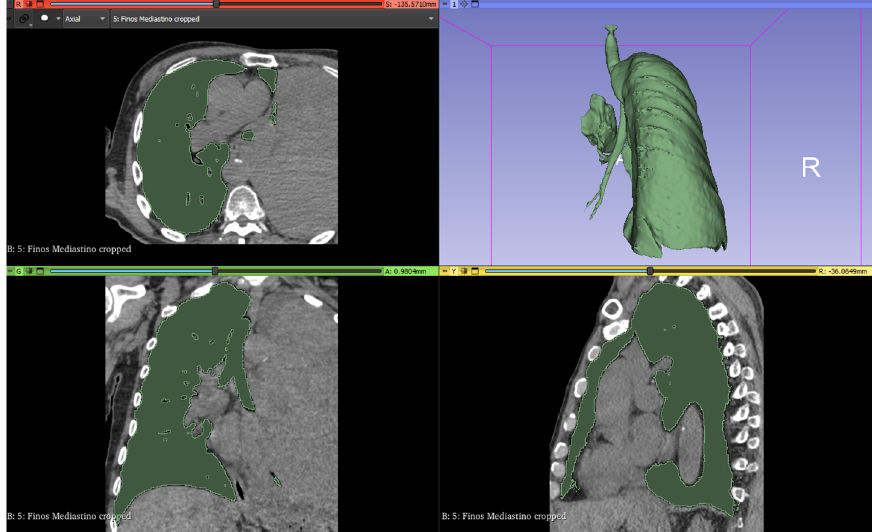
Figure 2. Lung segmentation in 3D Slicer.